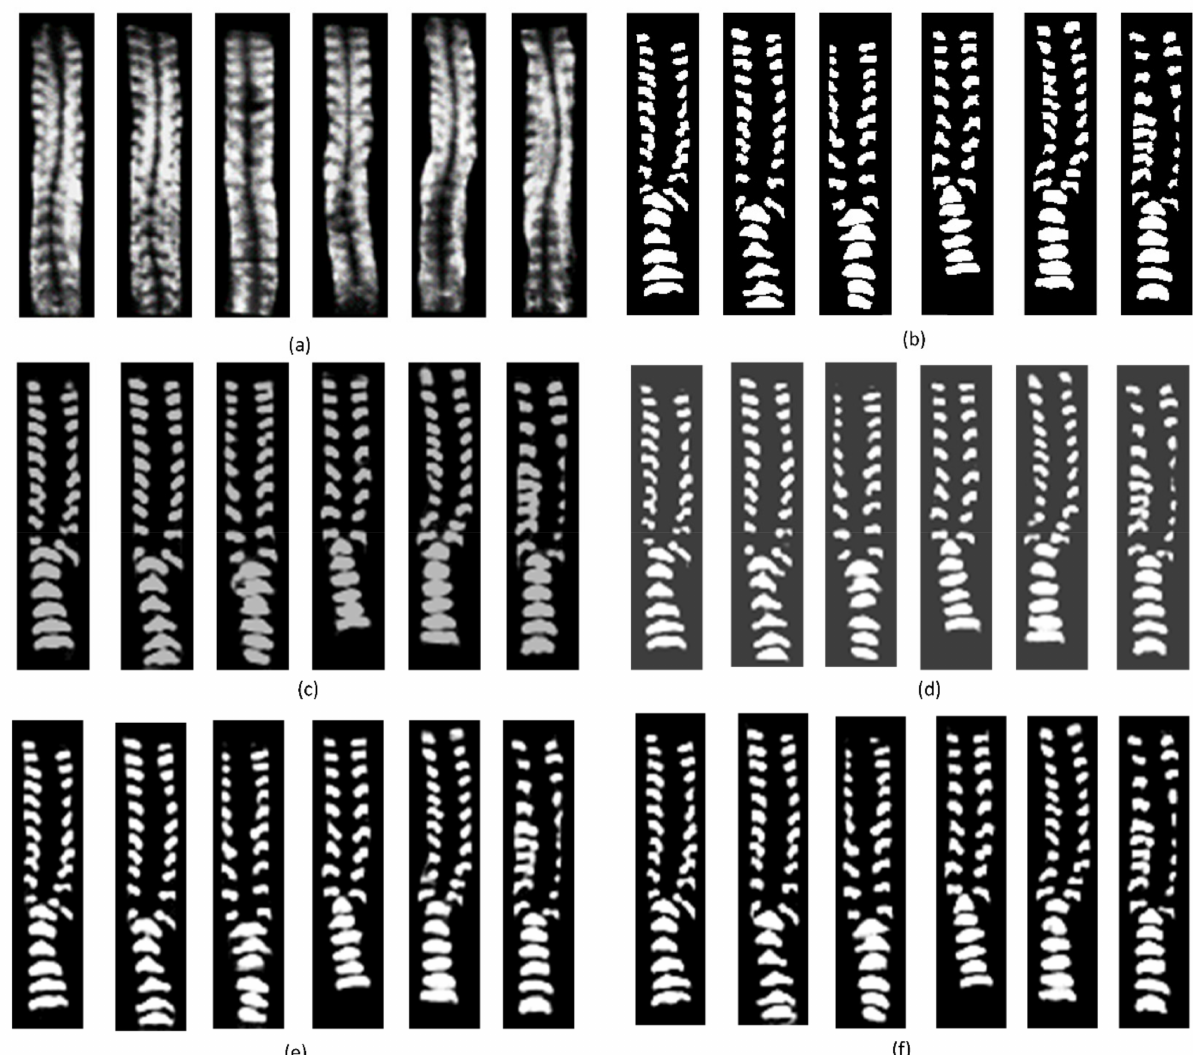
Figure 12. Qualitative comparison of 6 different case models: ( a ) Raw image ( b ) truth mask, ( c ) LD model, ( d ) LCS model, ( e ) LDI model, and ( f ) proposed LDS U-Net